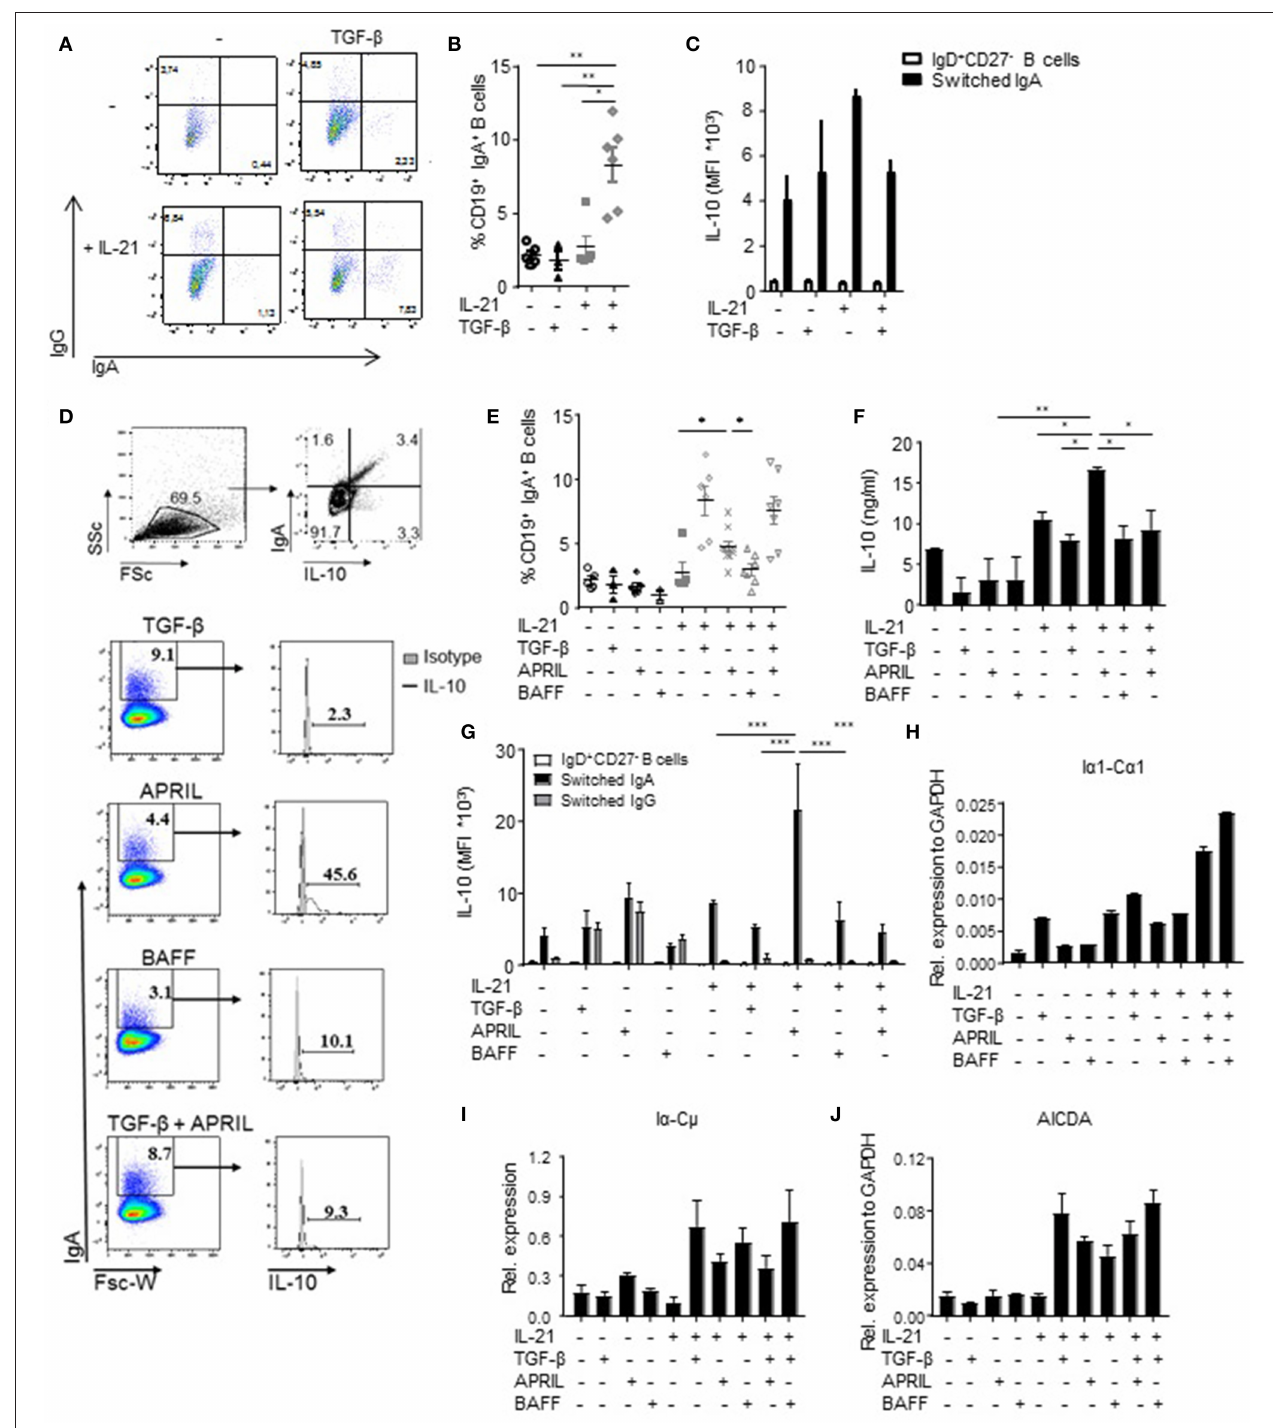
FIGURE 2 | APRIL is an important factor to induce CSR to IgA. (A) Representative dot plots of class-switched IgG + and IgA + CD19 + B cells at day 6 of culture in the presence of CD40L-expressing fibroblasts and IL-21 or TGF- β , or a combination of these factors. (B) Frequencies of CD19 + IgA + B cells after 6 days. N = 4-6, mean ± SD are shown. * P < 0.05, ** P < 0.01 (one-way ANOVA with Bonferroni multiple comparison test). (C) IL-10 production by naïve and class switched B cells cultured in the presence of IL-21, TGF- β or an combination, as measured by flow cytometric analyses of double-stained cells for IgA and IL-10. Mean ± SD are shown, n = 5. (D) Representative dot plots (upper part) and histograms (lower part) of class-switched IL-10-producing IgA + B cells at day 6 of culture in the presence of CD40L-expressing fibroblasts, IL-21 and indicated stimuli. Frequencies of IgA + B cells and IL-10-producing B cells within the IgA + subsets are